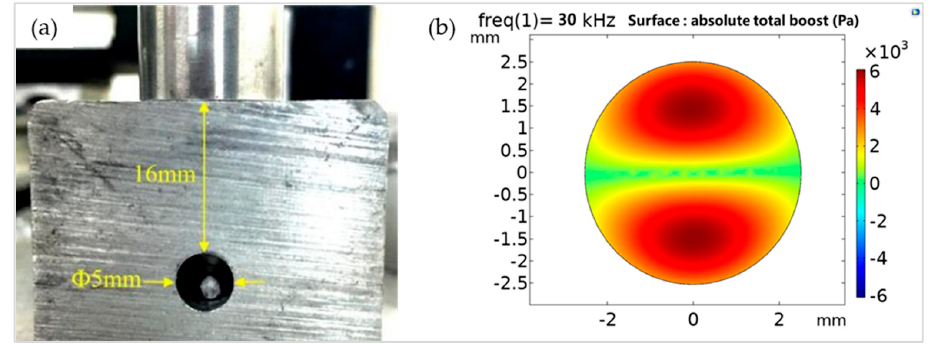
Figure 5. ( a ) Diagram of the three-dimensional acoustic levitation system; ( b ) Diagram of the nu- merical control system, which controls the stepper motor in ( a ). numerical control system, which controls the stepper motor in ( a